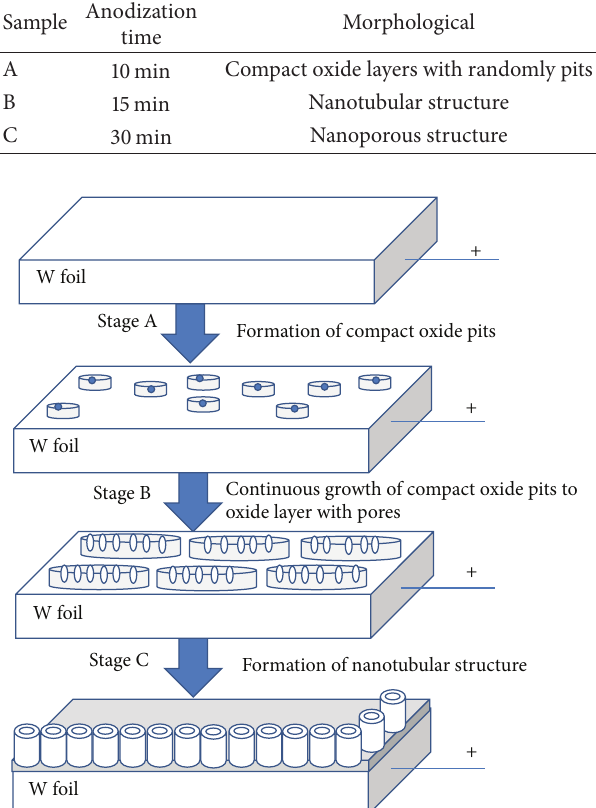
Table2:SelectedsamplesforMBdyedegradationbasedondifferent surface morphologies of anodic WO